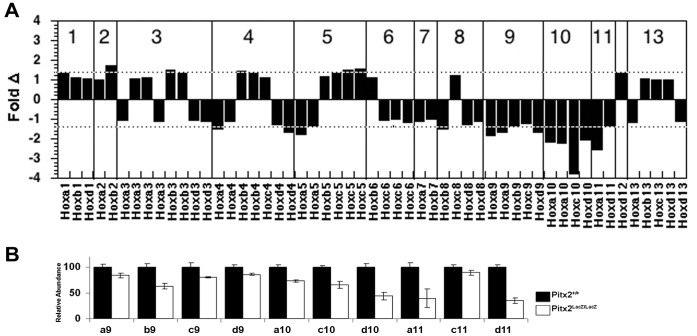
Expression Levels of Hox Genes in E10.5 Abdominal Wall Biopsies.(A) Fold changes in Hox expression levels in total RNA from E10.5 interlimb abdominal wall biopsies. The average signals from two biological replicate arrays, each made from pools of several embryos, are compared. Positive fold change indicates higher expression levels in mutants, or genetic repression by Pitx2. Negative fold change indicates lower expression levels in mutants, or genetic activation by Pitx2. The dashed lines indicate a false discovery rate of 11.5% at the ±1.4 fold threshold, determined by fold scanning analysis for three biological replicates, prior to removing the outlier set. The false discovery rate at this threshold is expected to be lower without the outlier. If multiple probe sets on the arrays monitored the expression of individual genes, then the probe set that produced the highest average signal intensity over all arrays is shown. This is generally the 3¢ most probe set on the transcription unit. (B) qPCR measurements on total RNA from E10.5 inter-limb body wall biopsies.